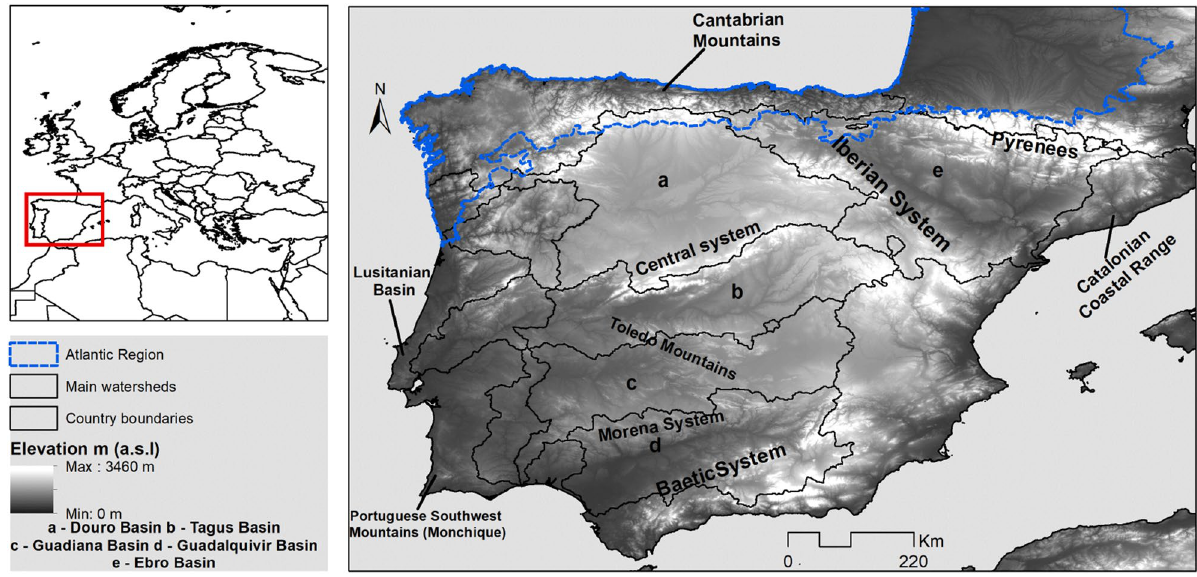
Figure 6. Study area (Iberian Peninsula) in the European context (left) and with the boundary of the Atlantic region highlighted in blue (right) and major river basins and mountain systems. Source: EEA. (European Environment Agency, Copenhagen, Denmark)